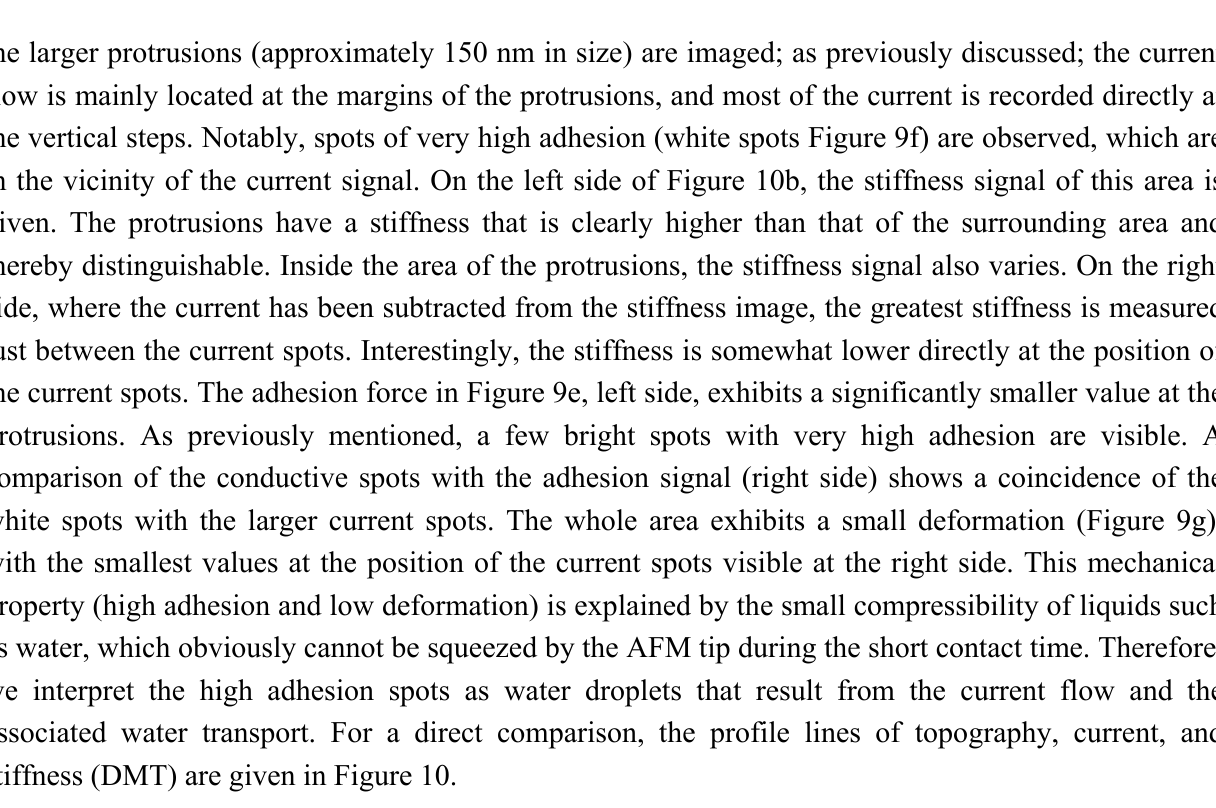
Figure 10. AFM measurement of the membrane in Figure 6 with mapping of topography ( a ), stiffness ( b ), and profiles of the topography ( c ) and current ( d ) of the membrane from Figure 7b with the addition of the stiffness profile ( e ) along the same line; the stiffness values are enhanced at swollen regions. The stiffness is slightly decreased directly at the site of current flow (compare with ( d ) and ( f